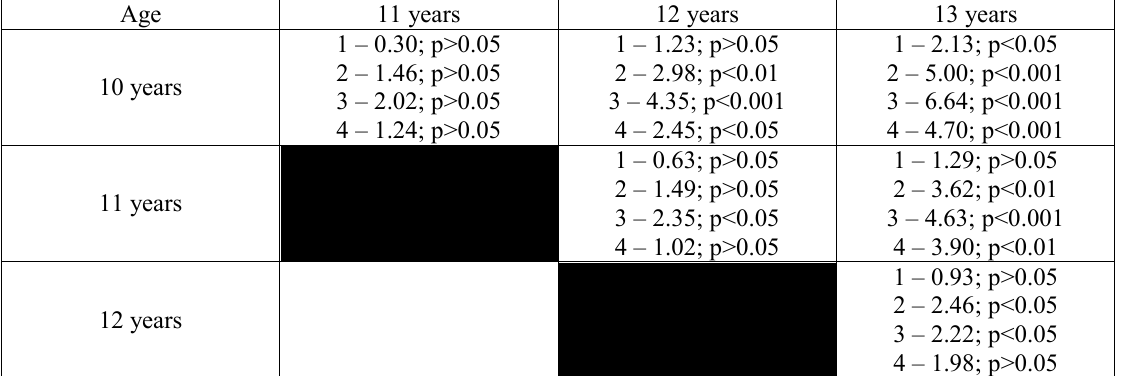
Matrix of indices changes reliability for 30 m run of 10-13 aged boys from different groups (n 1 =n 2 =n 3 =n 4 =18)